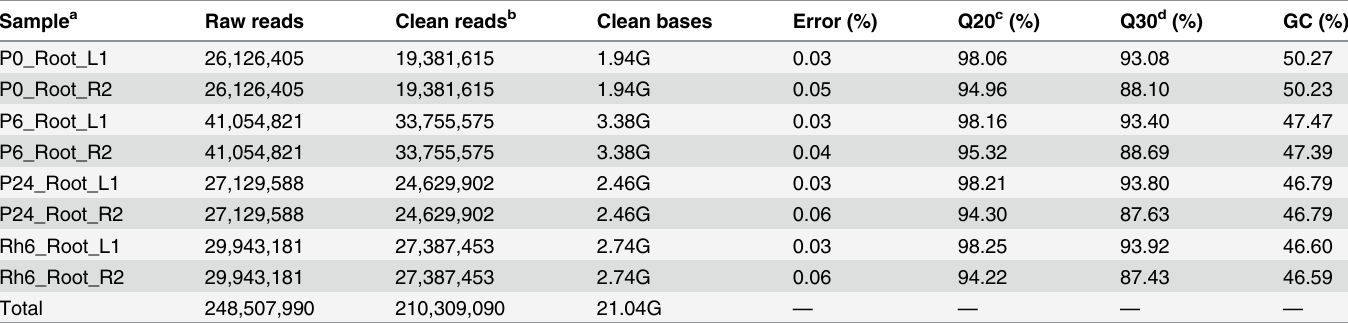
Table 1. Overview of the sequencing reads. Sample a